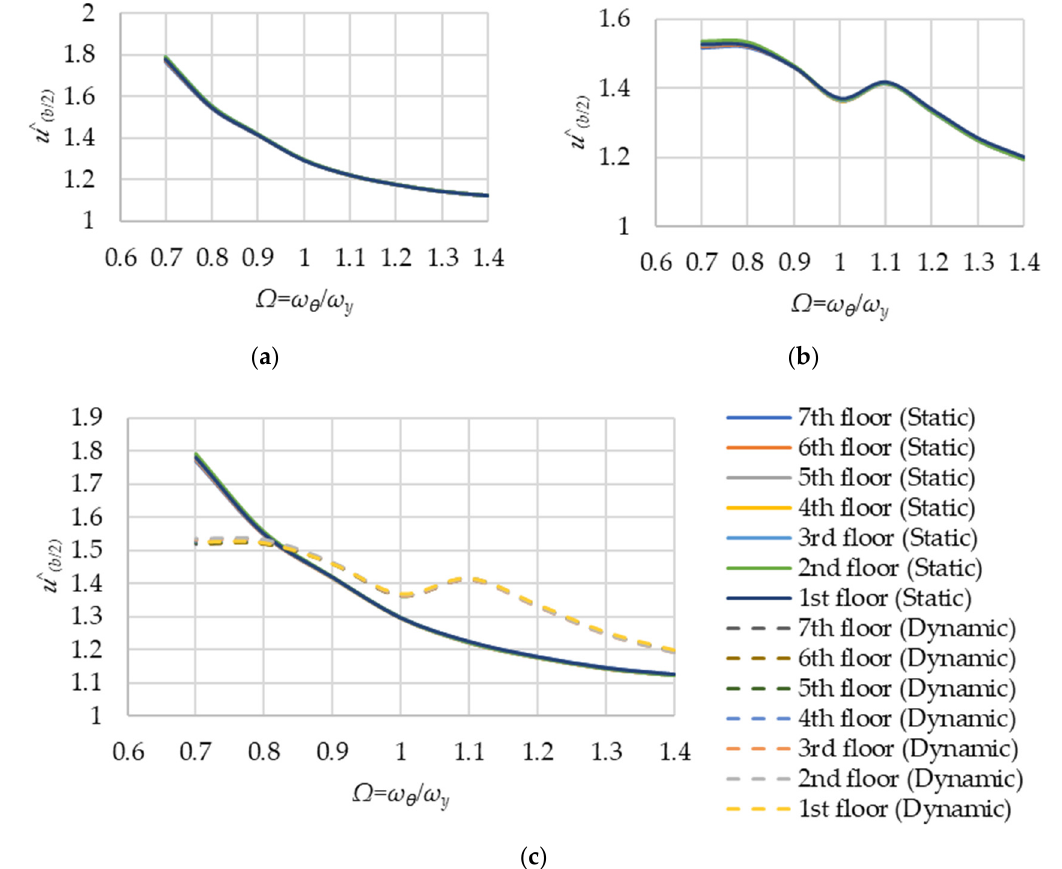
Figure 5. Normalized flexible edge displacement (with b / r = 1.1, Ty < 1 s): ( a ) Static edge displacement; ( b ) Dynamic edge displacement; ( c ) Static vs. dynamic edge displacement.